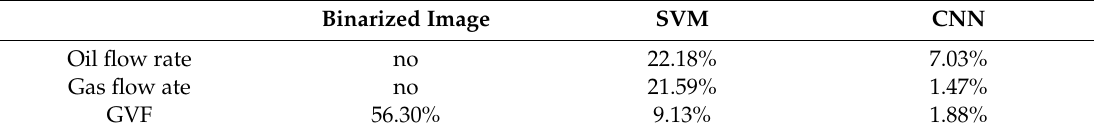
Table 3. Average relative error table of prediction of data after the venturi tube.